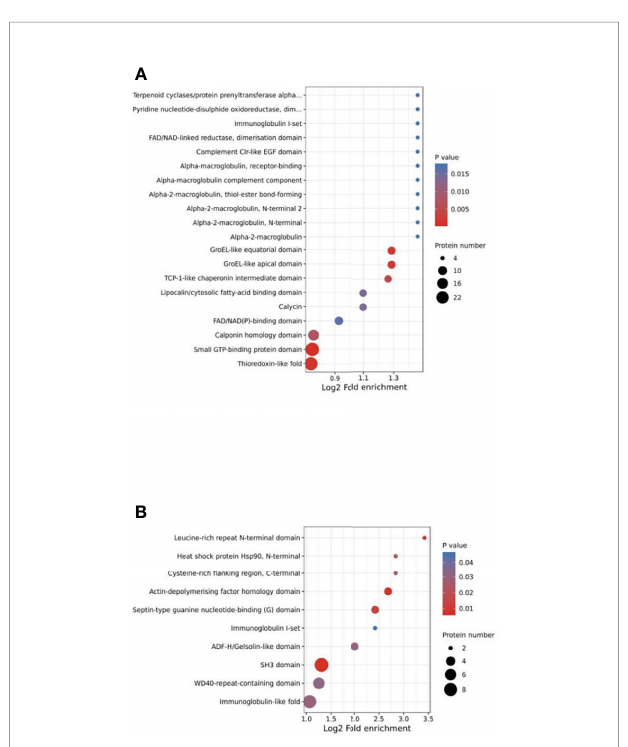
FIGURE 6 | Protein domain enrichment analysis of DEPs (A) and DPPs (B) .